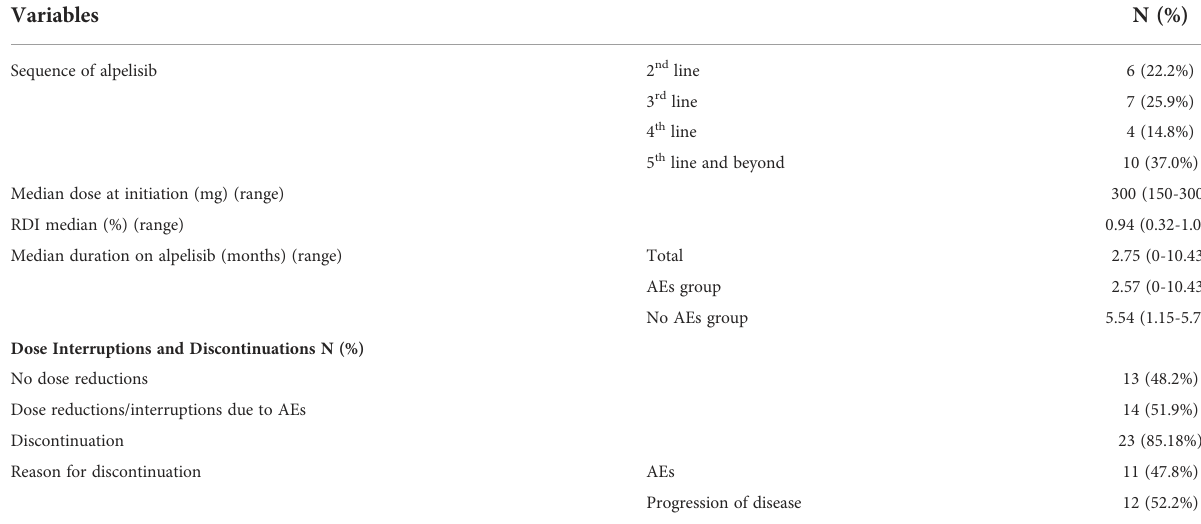
TABLE 4 Alpelisib treatment